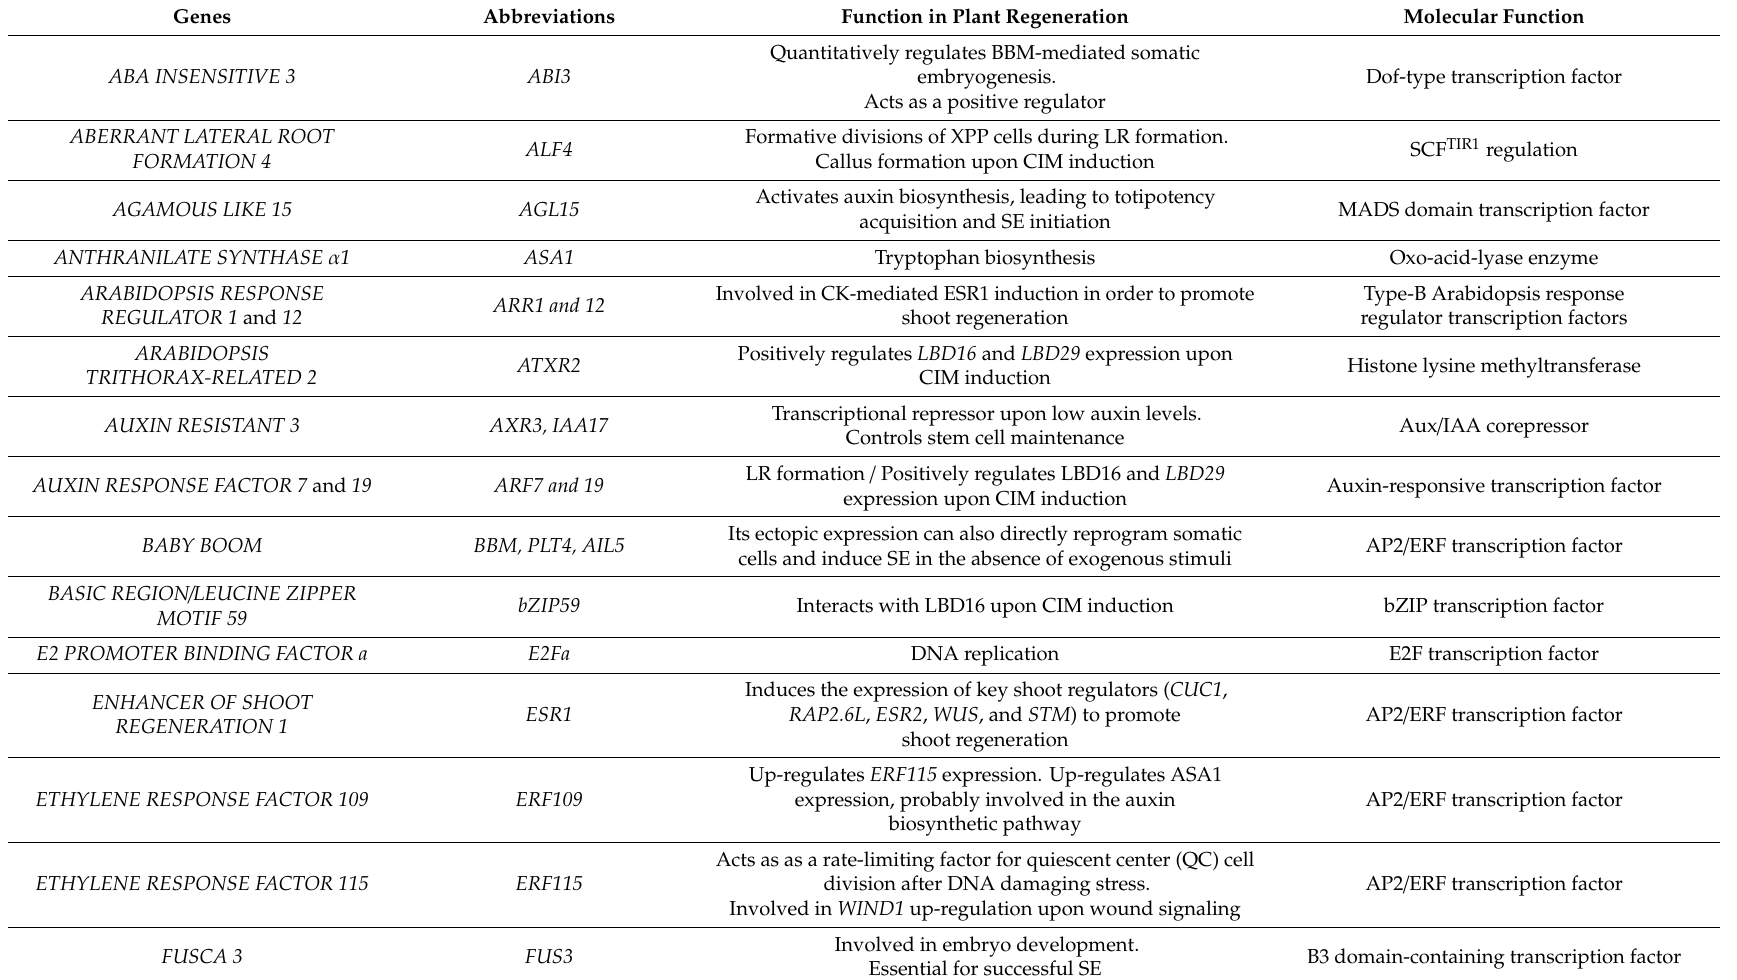
Table 1. Some key regulatory factors (transcription factors, epigenetic regulators and others involved in auxin homeostasis) involved in plant